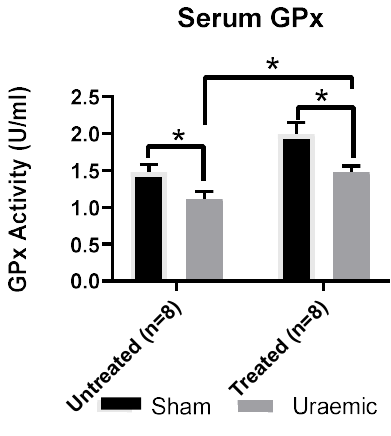
Figure 5. Serum glutathione peroxidase activity. Systemic anti-oxidant capacity was investigated through the measurement of glutathione peroxidase activity in the serum of uraemic and sham animals. Results are presented as mean ± SEM (* p < 0.05).